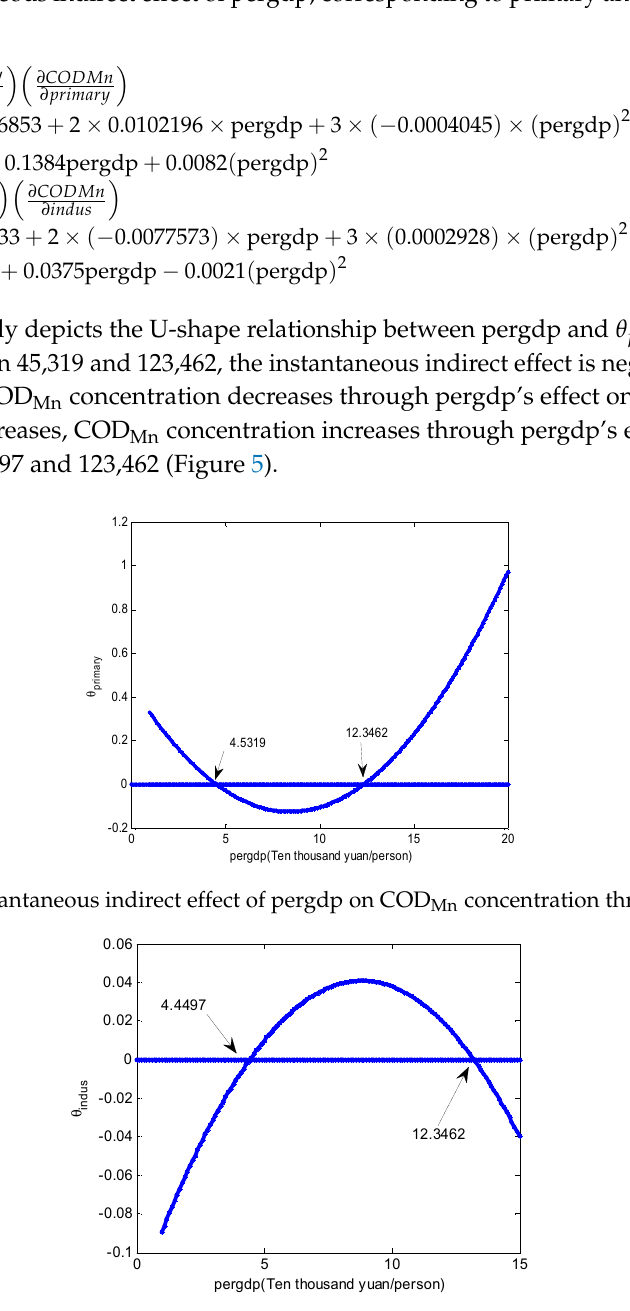
Figure 5. The instantaneous indirect effect of pergdp on CODMn concentration through indus.